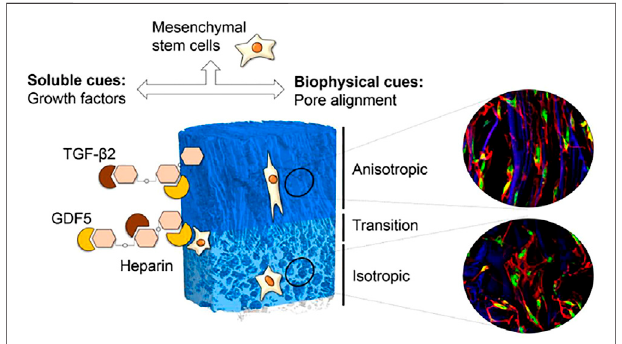
FIGURE4| Delivery ofGDF-5withfunctionalized scaffoldsand their role in IVDs repair. The combined impact of GDF-5 and pore alignment can drive MSCs differentiate towards the desired NP cells phenotypes for IDD repair. Engineered scaffolds guide spatial positioning of GDF-5 at speci fi c regions and the temporal control of quantal growth factors release. The delivery of GDF-5 enhanced the expression of markers and collagen II protein content on substrates with isotropic porosity. Reproduced from Font Tellado et al. (2018) with permission from Copyright 2018 Elsevier.